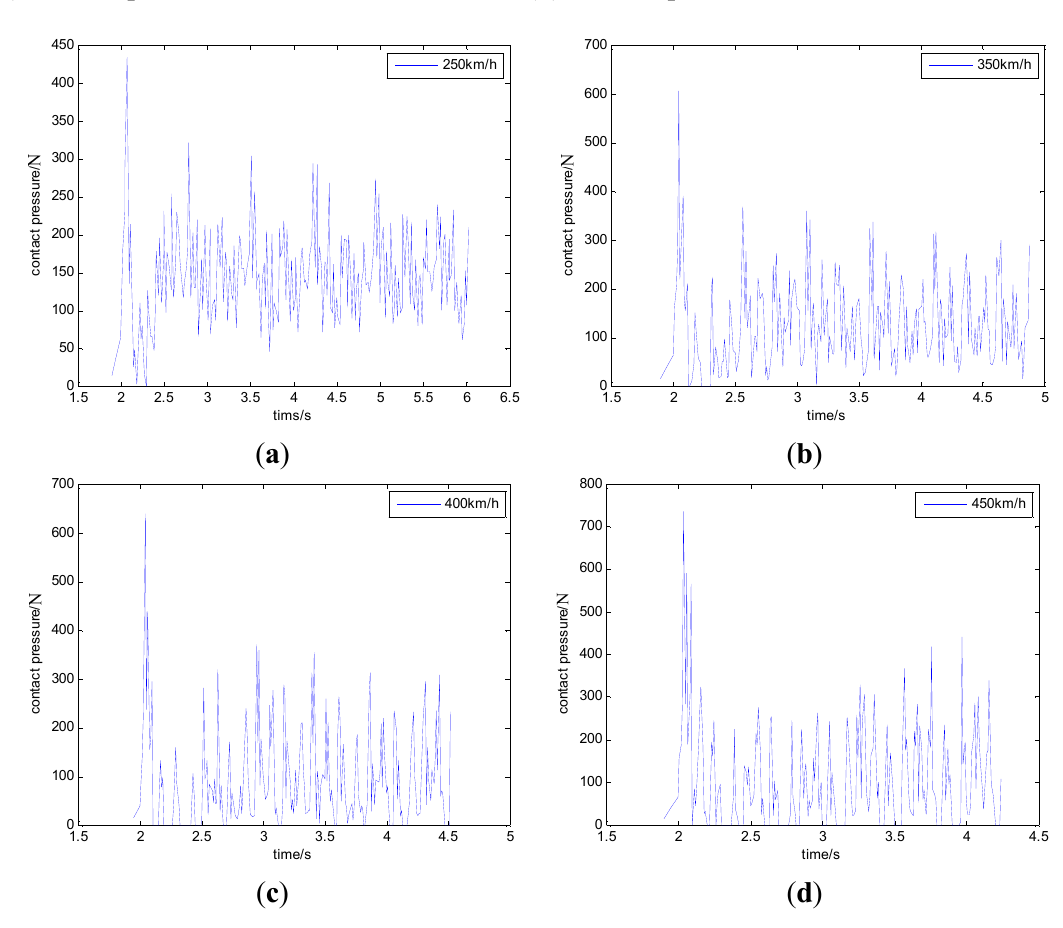
Figure 3. ( a ) Contact pressure curves of 250 km/h; ( b ) Contact pressure curves of 350 km/h; ( c ) Contact pressure curves of 400 km/h; and ( d ) Contact pressure curves of 450